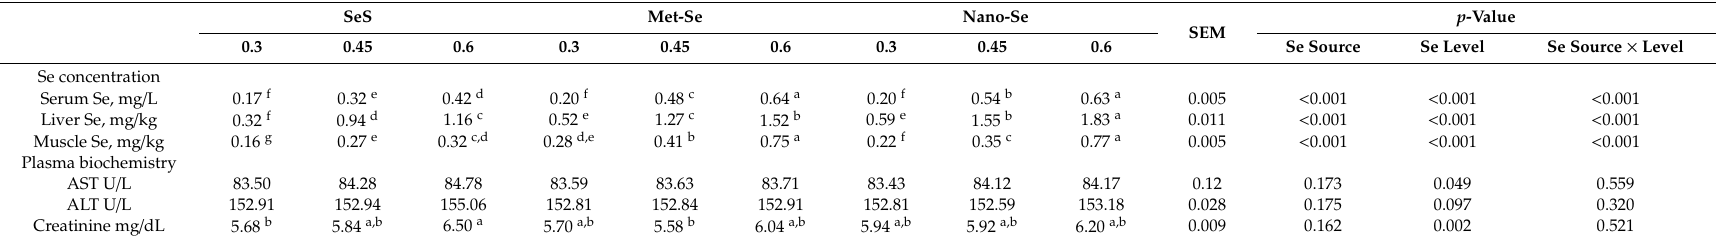
Table 3. E ff ects of dietary Se sources and levels on Se concentration and some plasma biochemical parameters of broilers over 38 days 1 . SeS Met-Se Nano-Se